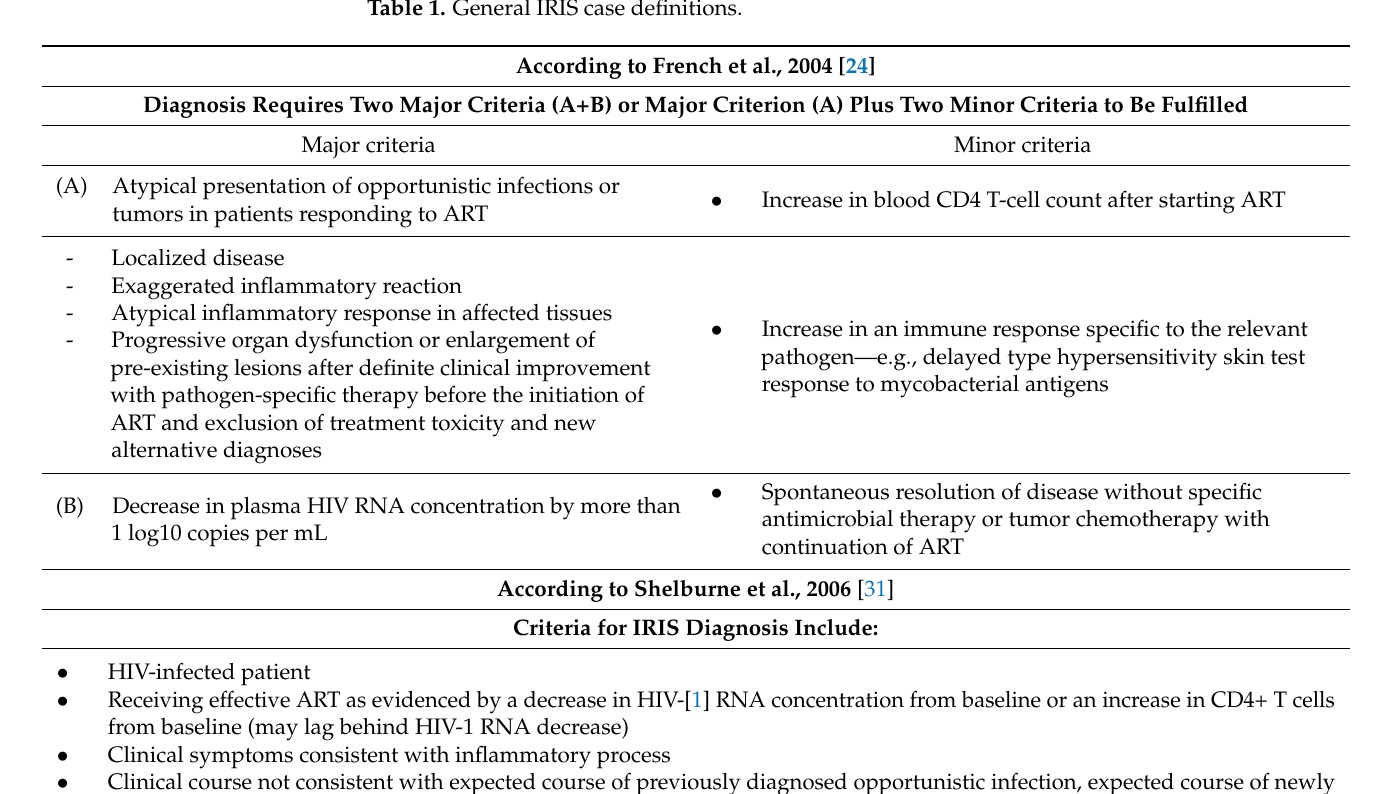
Table 1. General IRIS case